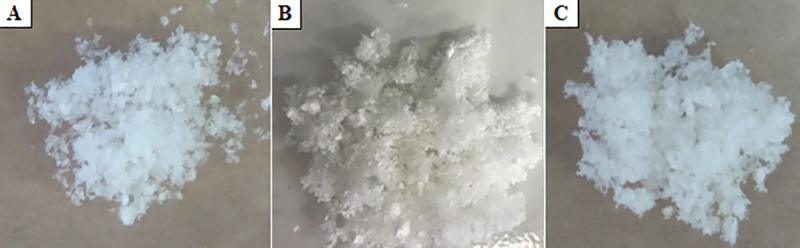
Powder encapsulates containing quinoa oil (Chenopodium quinoa Willd.) obtained by O/W emulsification technique.(A) OG: Quinoa oil and porcine gelatin in aqueous phase 2; (B) OWG1: Quinoa oil, whey protein isolate and porcine gelatin in aqueous phase 2; (C) OWG2: Quinoa oil, whey protein isolate in aqueous phase 1, and porcine gelatin in aqueous phase 2.